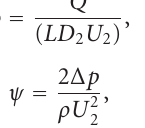
Figure 6: The zonal grids including the porous stabilizer.